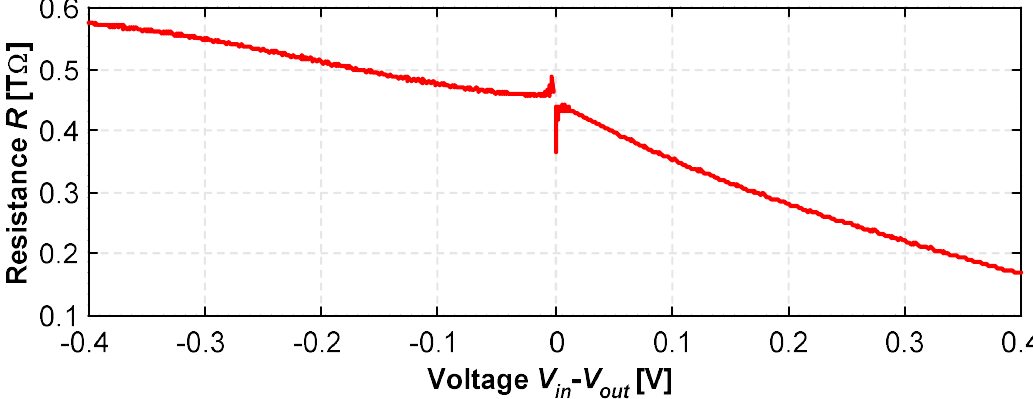
Figure 6. Voltage dependence of the pseudo resistance.